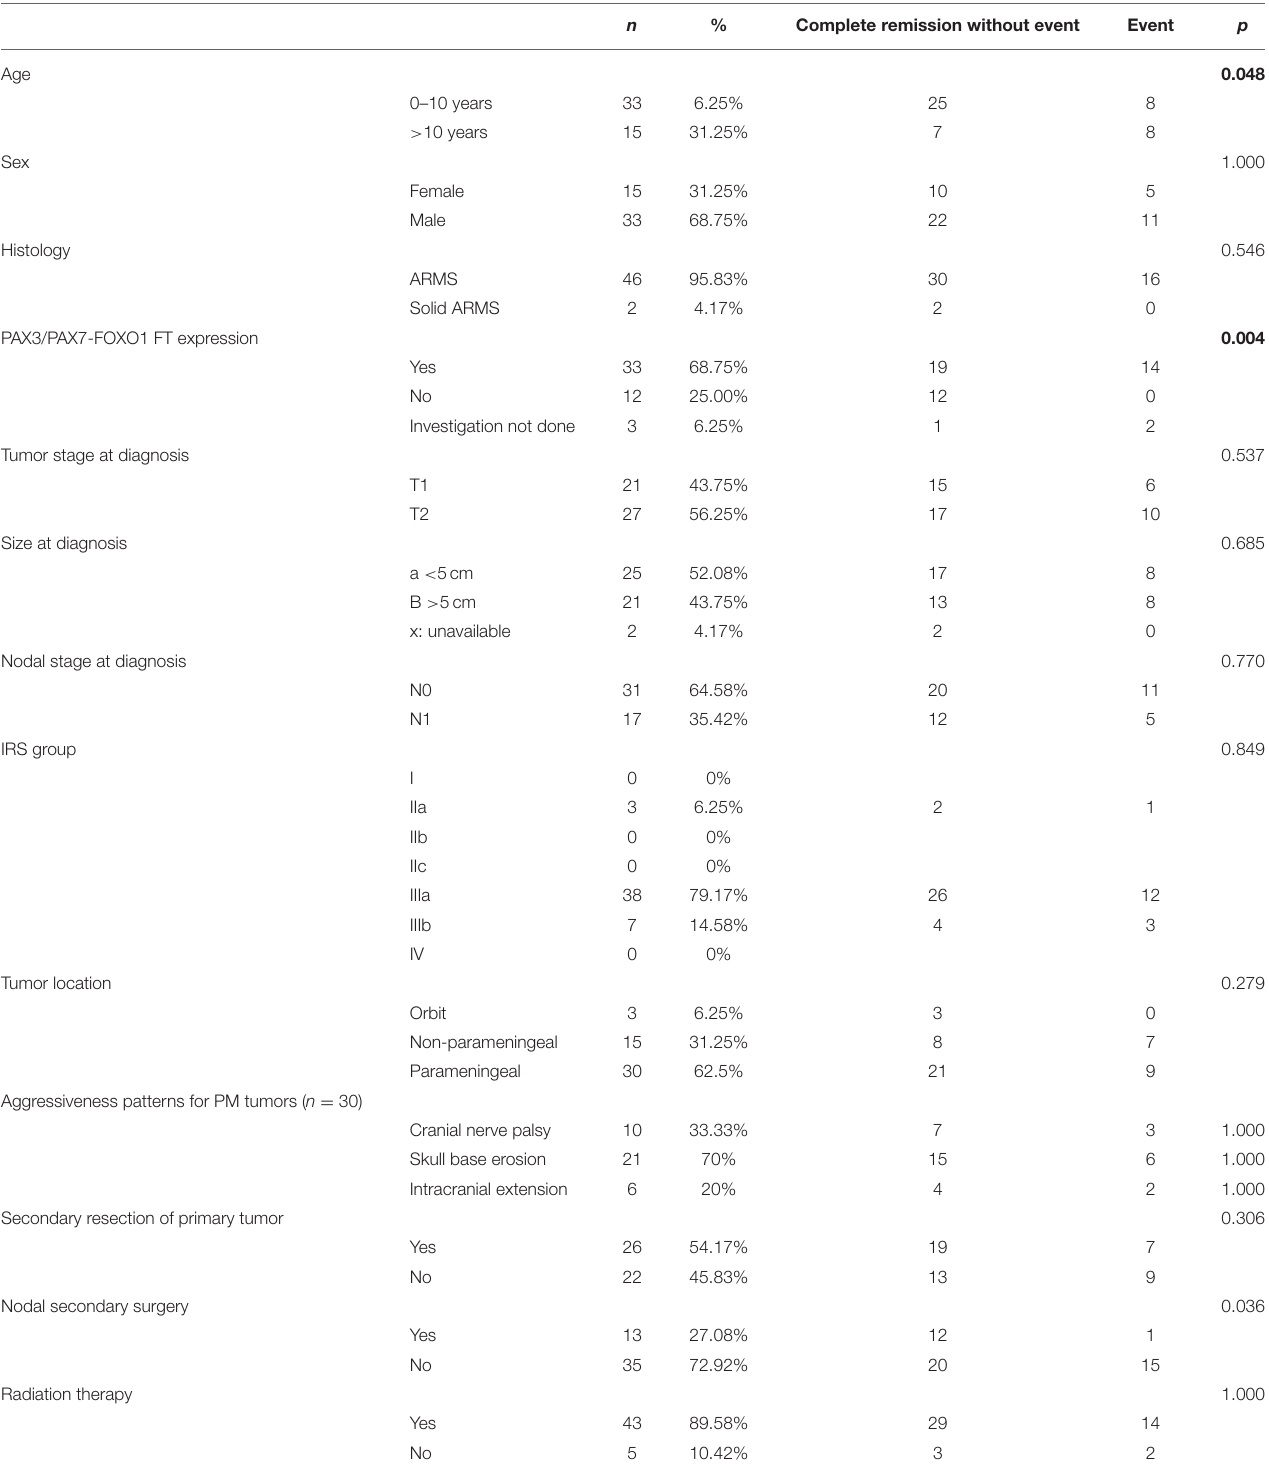
TABLE 4 | Univariate analysis of events according to patients and tumor characteristics and treatment for the 48 HN-ARMSs.